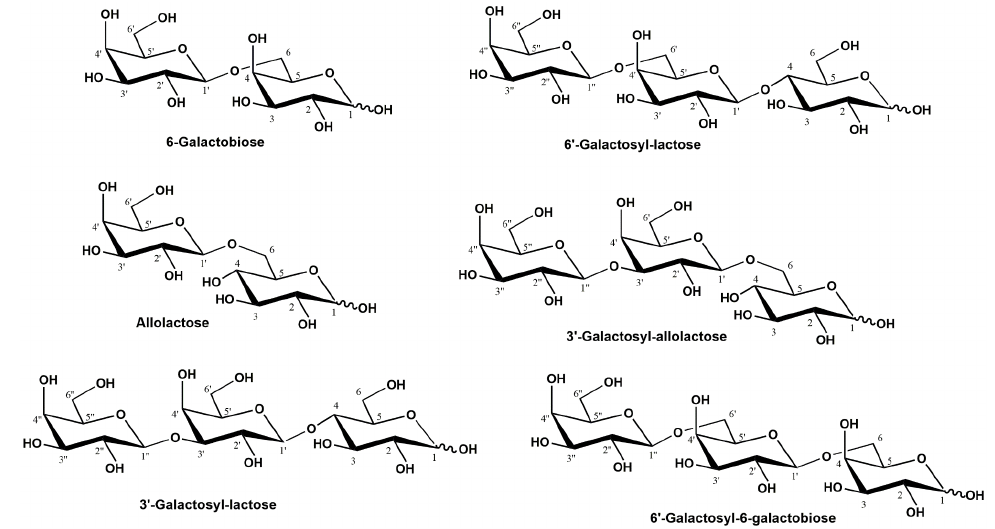
Figure 2. Structures of main six GOS obtained in the reaction with P. anthophila permeabilized cells.